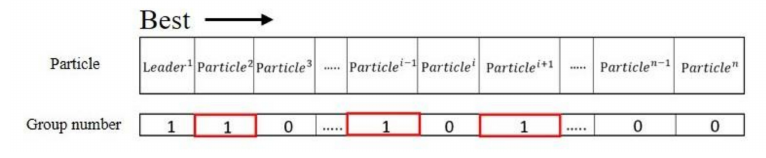
Figure 6. Particle grouping diagram.